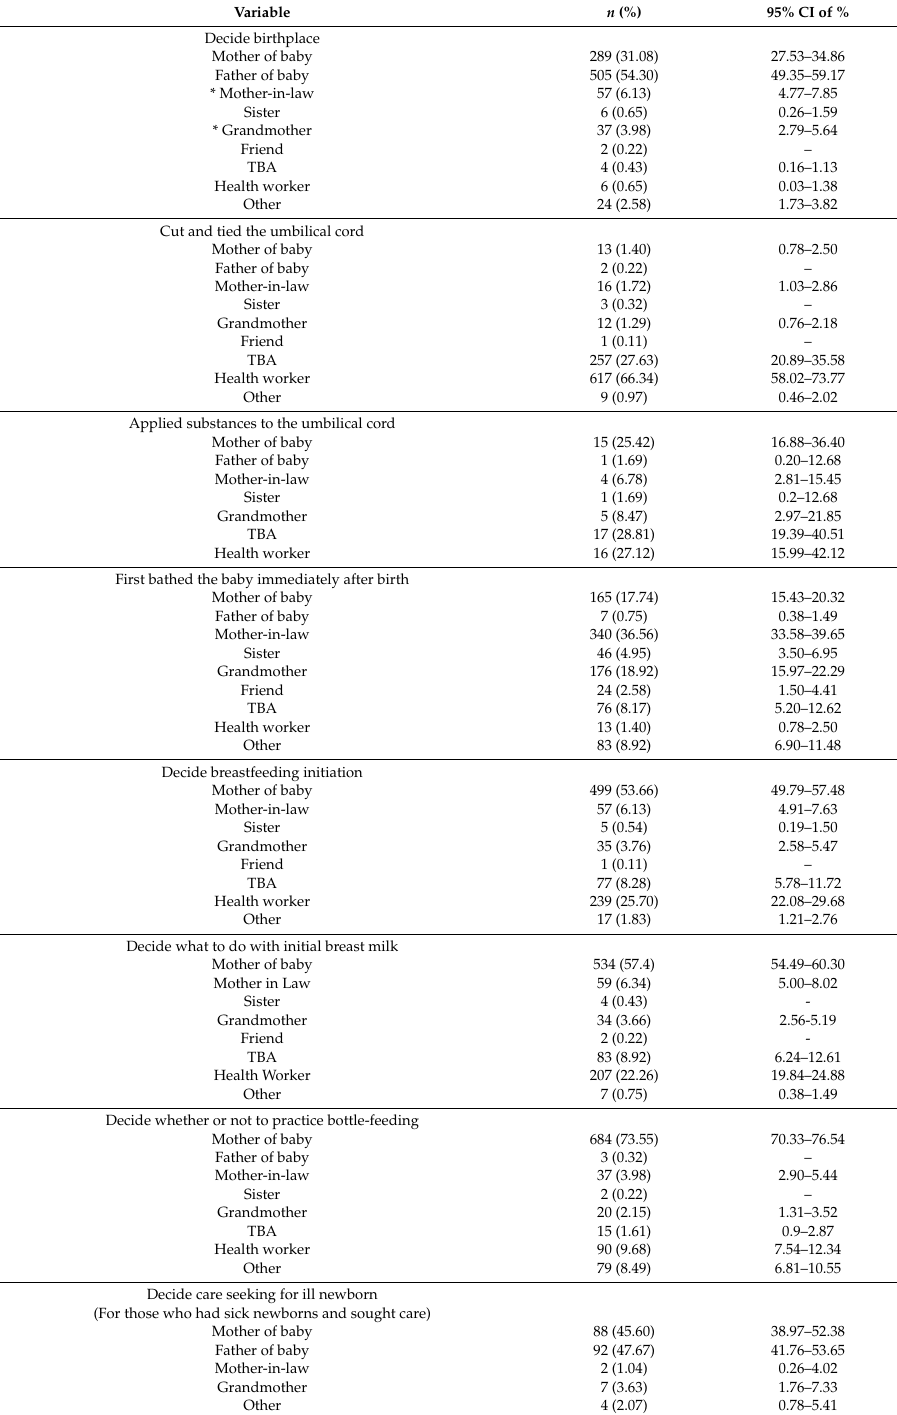
Table A1. Table showing a detailed list of key decision makers and actors in newborn care in the Lira district, Northern